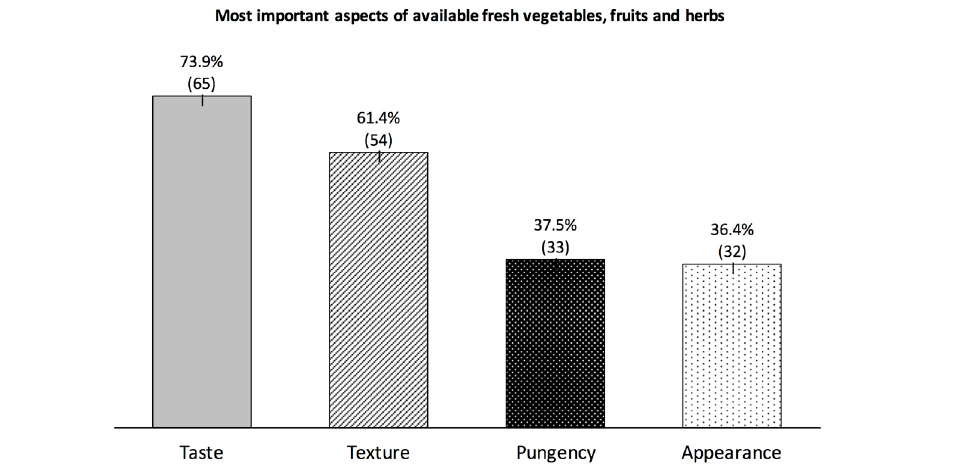
Figure 3: The 85% of respondents indicating that the availability of fresh fruit, vegetables and herbs grown on the Neumayer Station (85%, 88 individuals) would improve their overall well-being were asked to indicate which aspect of available fresh fruits and vegetables they would have enjoyed during their stay. They could choose between one to four of the four aspects. The presented data consists of a total of 184 answers. Numbers in brackets are the total responses for each